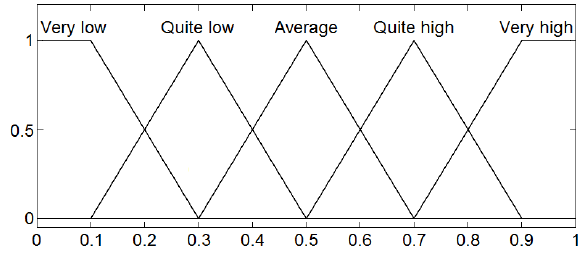
Figure 5: Membership function for the input variable x 2 – EFF(Uph) , polygonal functions (piecewise linear)